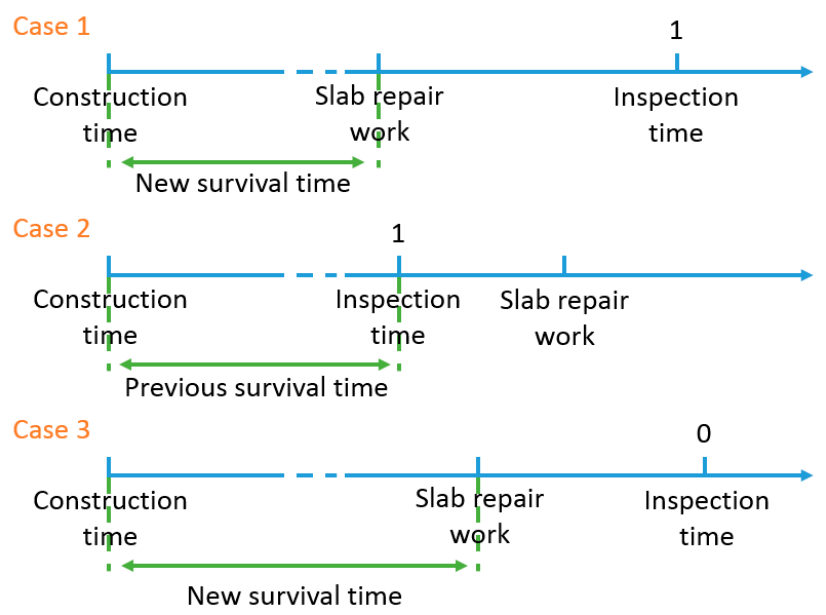
Table 4. Repair types in Tokyo region.